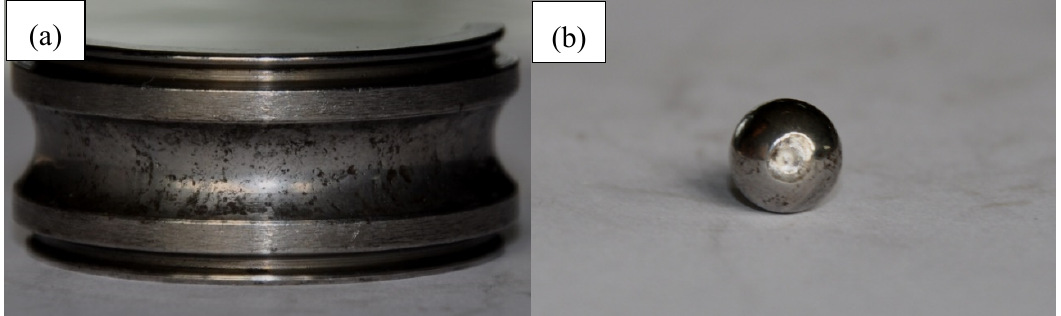
Figure 8. High speed (HS) shaft bearing outer race faults: ( a ) left bearing; ( b ) right bearing.